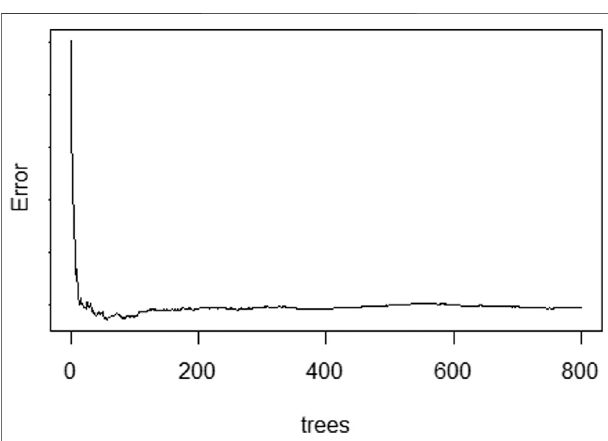
FIGURE 4 | Random forest OOB error based on the number of